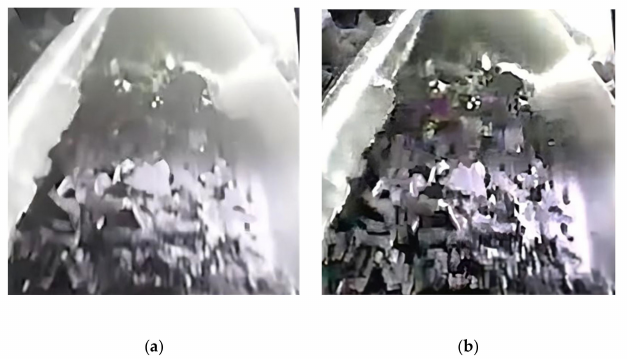
Figure 8. Comparison before and after preprocessing. ( a ) Image before preprocessing. ( b ) Image after preprocessing.